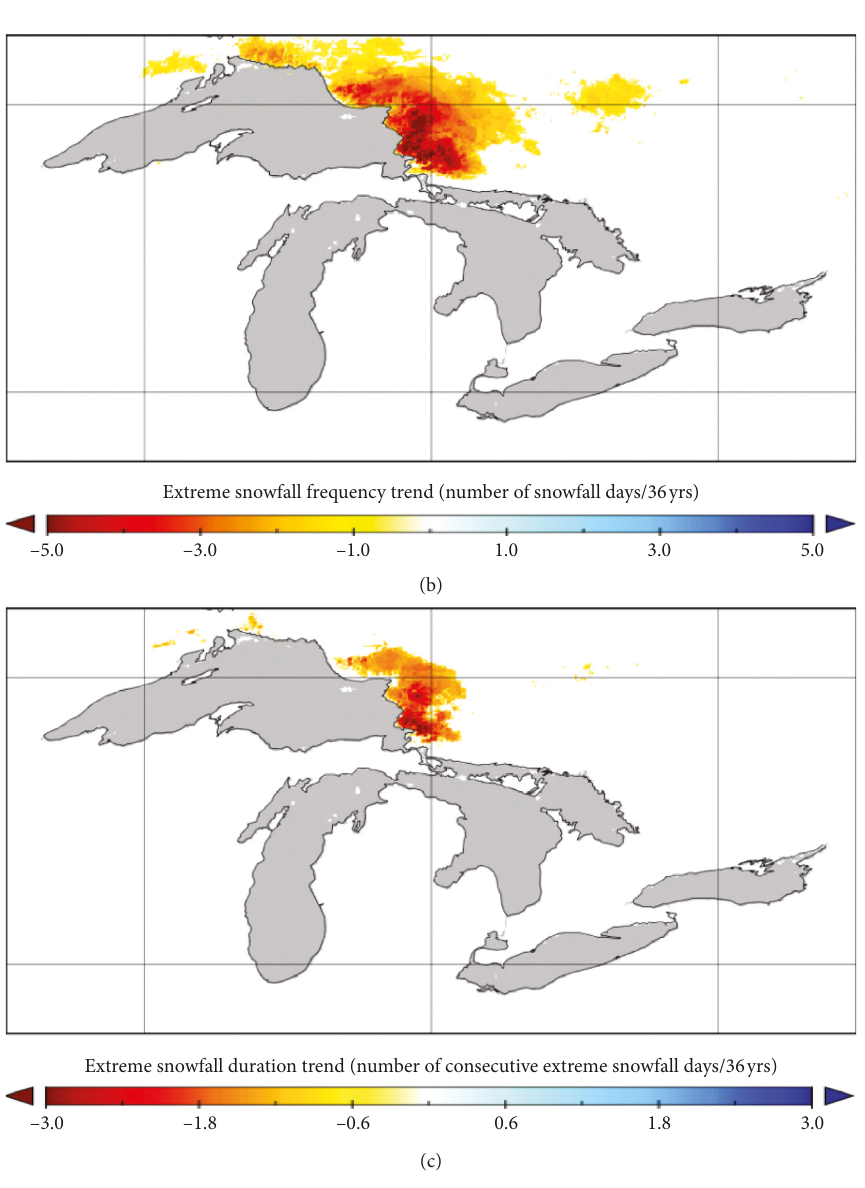
Figure 6: 1980 to 2015 trends in extreme snowfall (a) intensity, (b) frequency, and (c) duration, for the month of December. Gray pixels represent grid cells with no trend computed because the region contains some years with no extreme snowfall